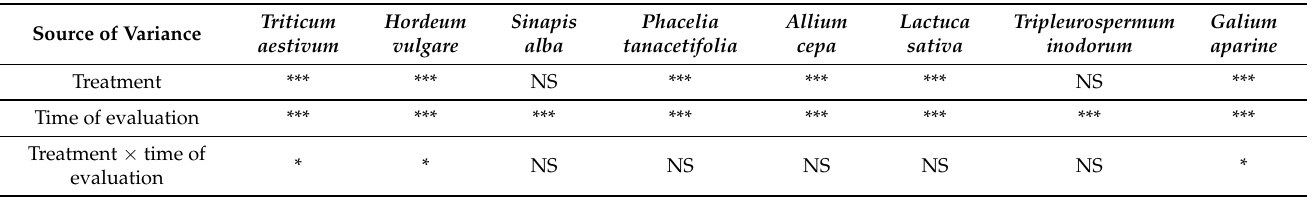
Table 2. Summary of analysis of variance for germination of selected species according to treatment and time of